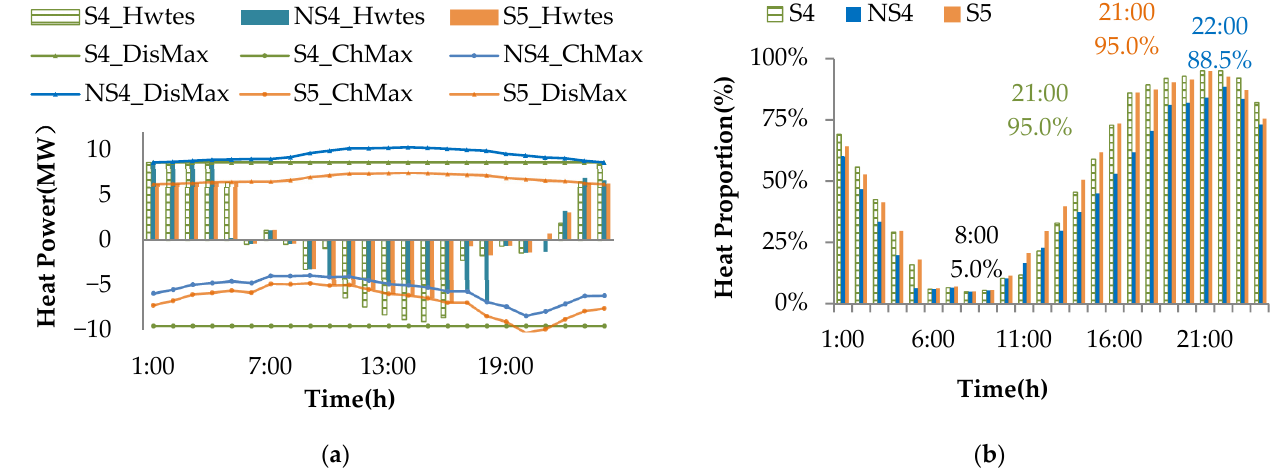
Figure 11. Operation state of WTES at node H4: ( a ) heat power and ( b ) heat proportion.